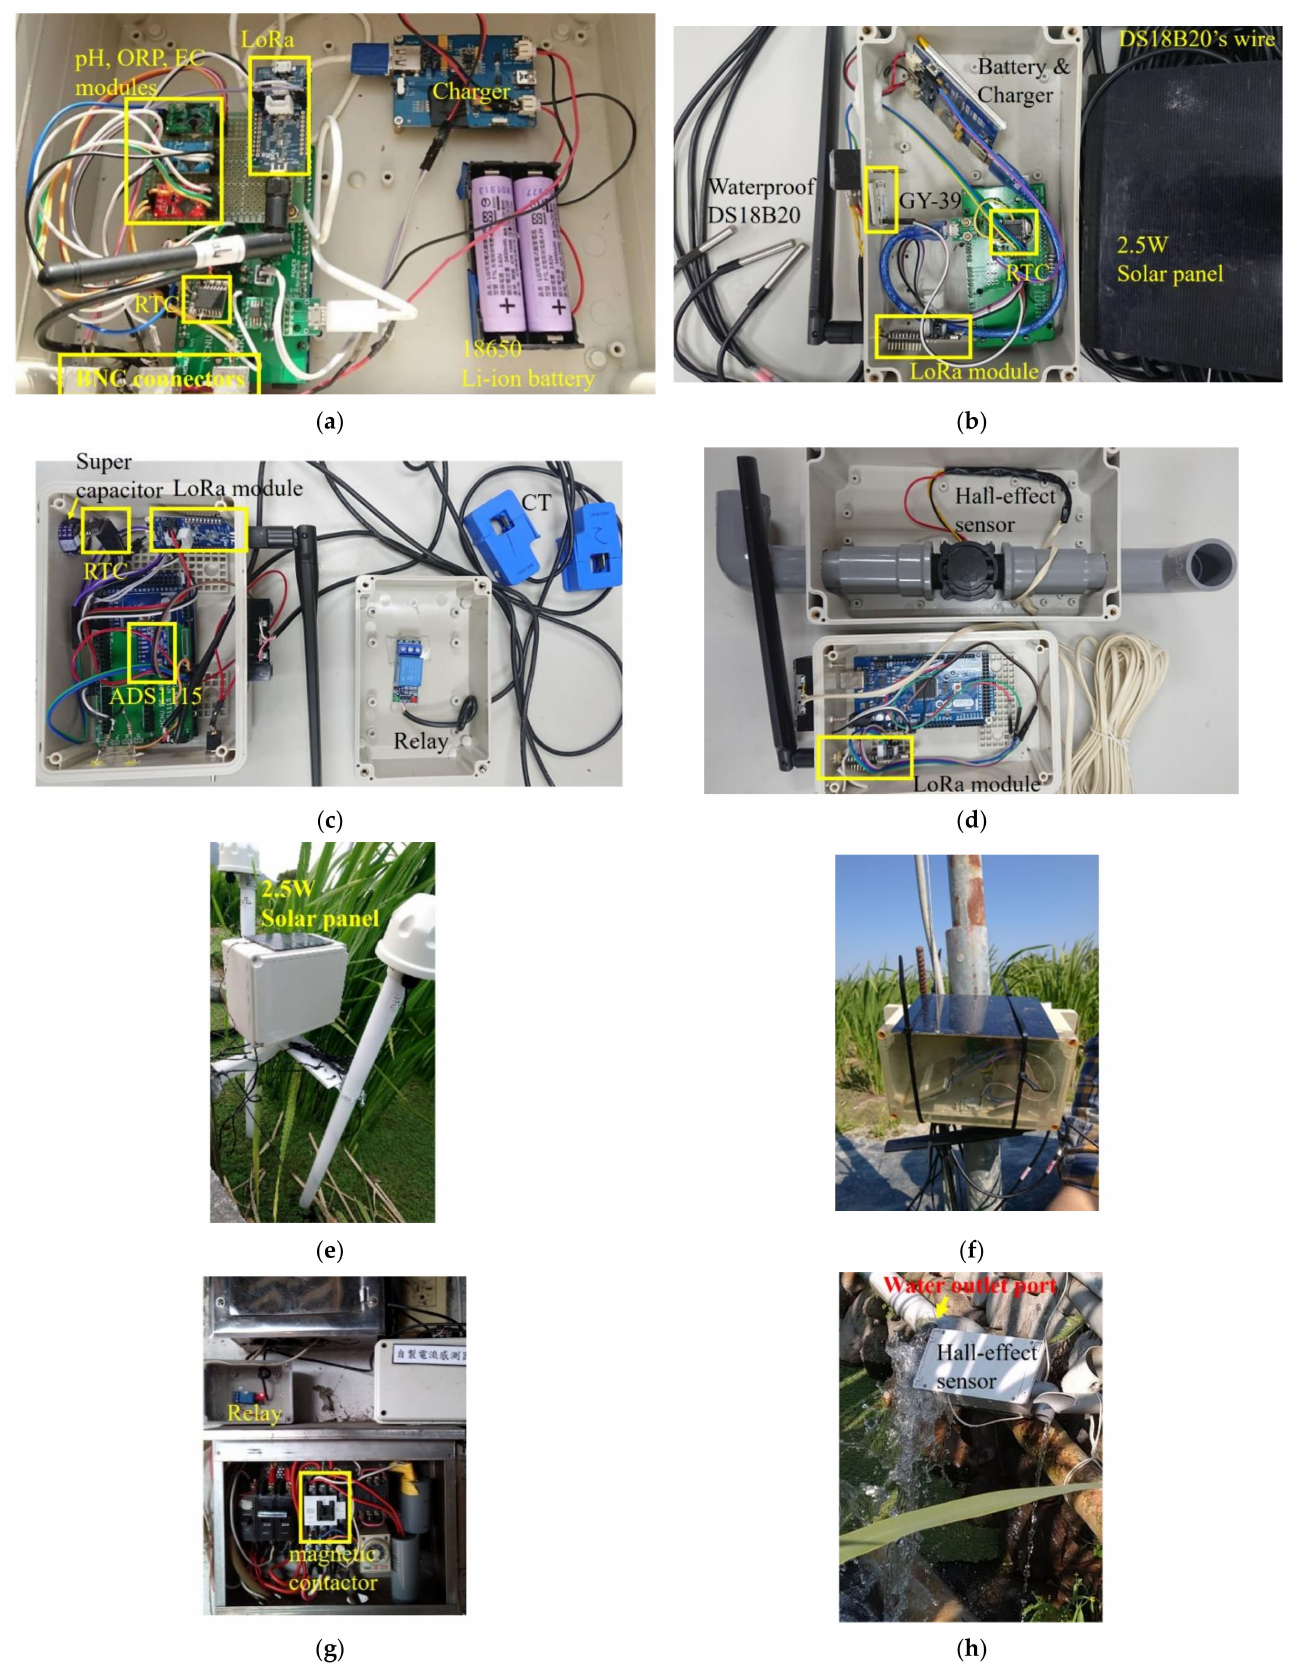
Figure 8. ( a – d ) Finished units and ( e – h ) actual unit